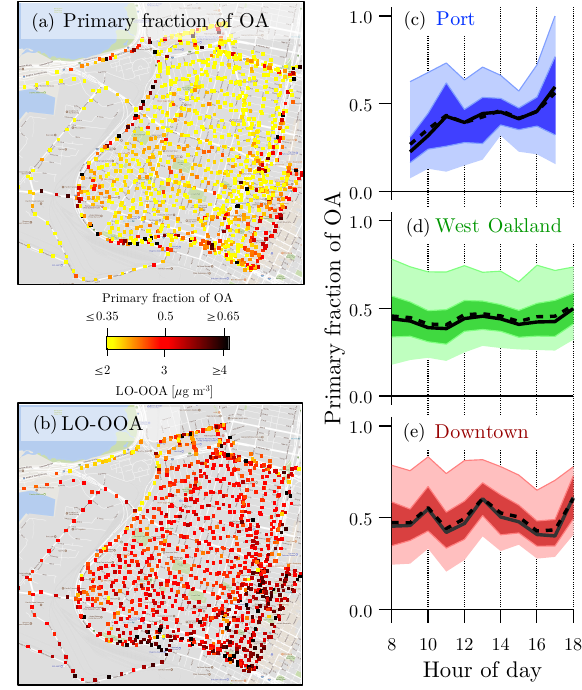
Figure 5. (a) Median primary fraction of OA at each magnet. Pri- mary fraction is defined as the ratio of COA + HOA to the total OA at each magnet. (b) Median LO-OOA concentration at each mag- net. Also shown are diurnal profiles of the primary OA fraction in (c) port, (d) West Oakland, and (e) downtown. Solid and dashed lines are hourly medians and means, respectively. Darkly shaded areas enclose the first and third quartiles of data. Lightly shaded areas enclose the 5th through 95th percentiles of